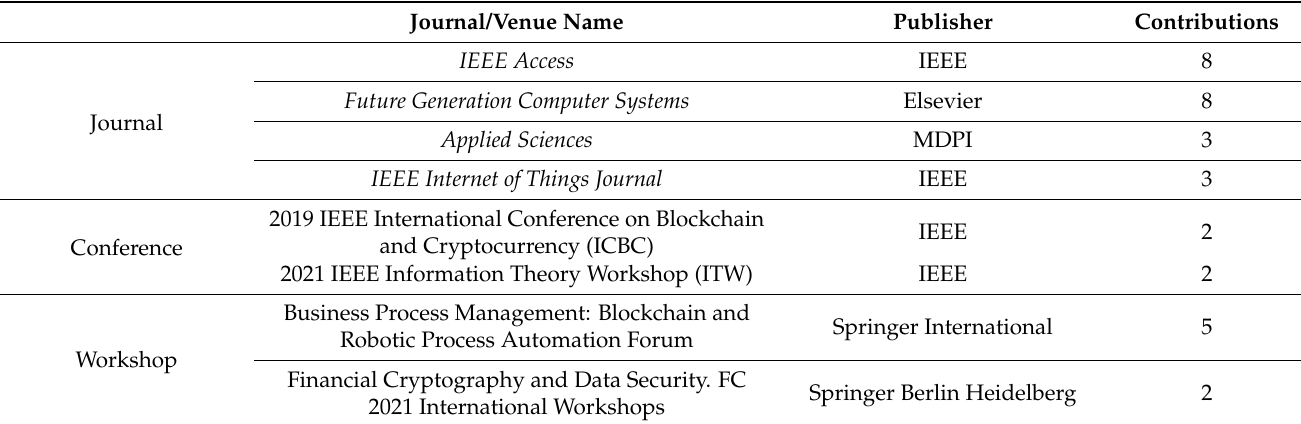
Table 6. Documents by